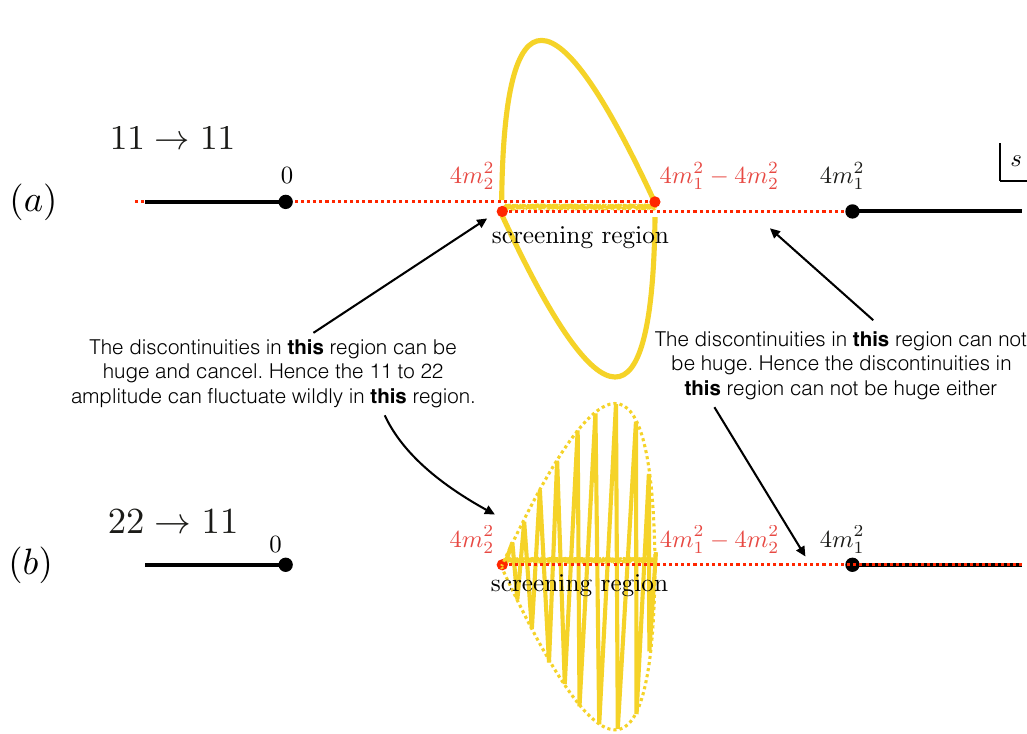
Figure 19. The s- and t- channel discontinuities come with opposite signs. As such, when there is an overlapping region as in the 11 11 amplitude represented at the top, they can both be ! very large as long as their sum remains bounded and does not lead to violation of unitarity in the physical region represented by the black solid lines at the top. Furthermore the discontinuity of M 11 22 (at the bottom) in that same kinematical region is bounded by the Im M 11 11 and has no ! ! de(cid:12)nite sign. Therefore, in the region where Im M 11 11 is unbounded, the amplitude M 11 22 can ! ! take advantage of